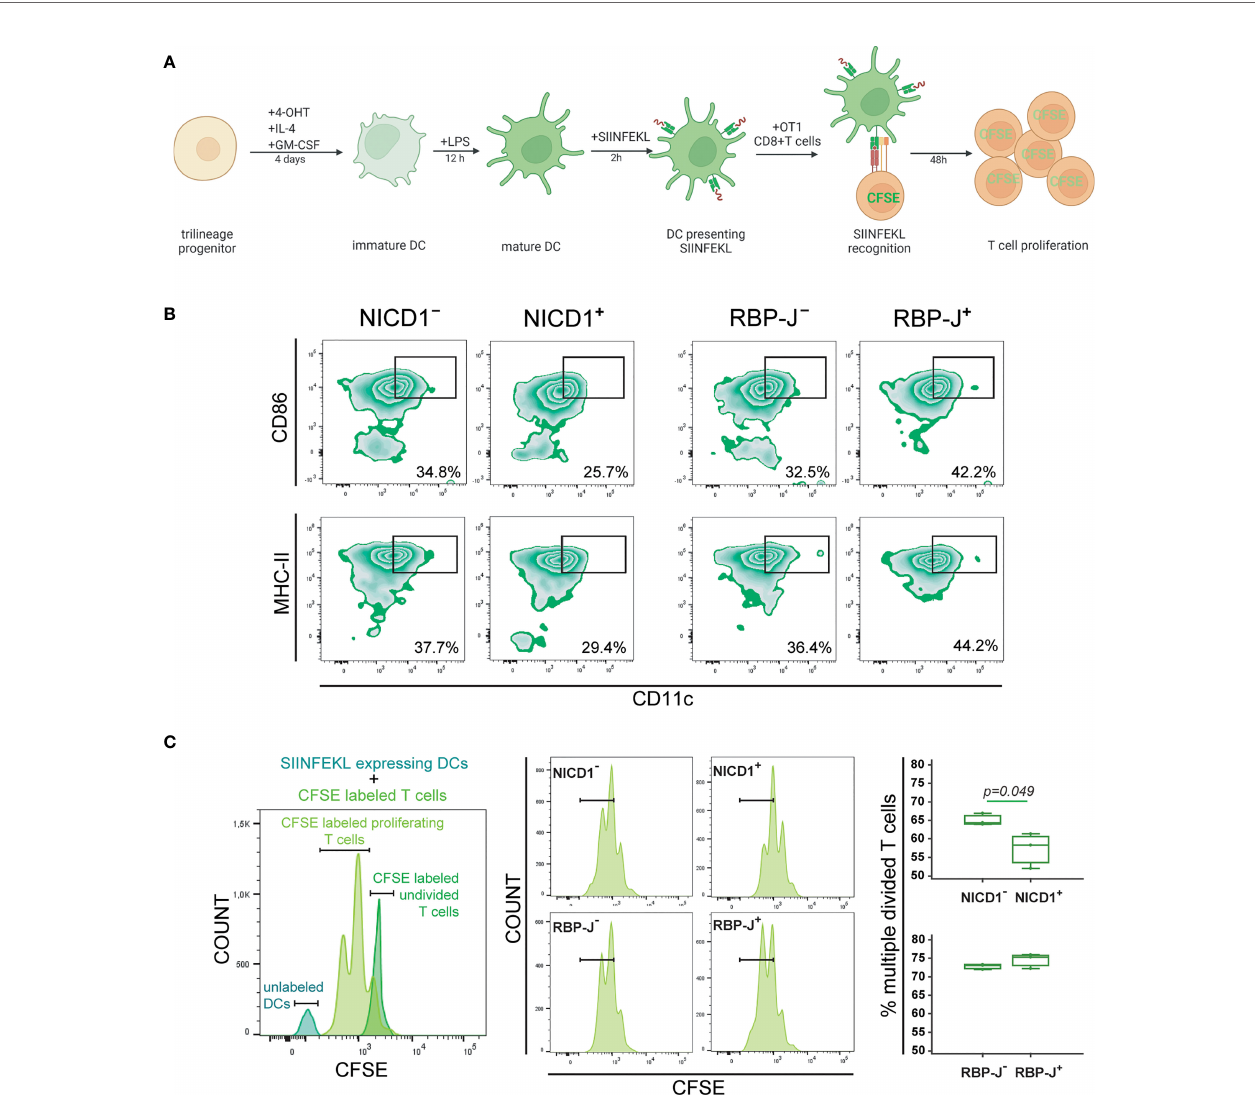
FIGURE 7 | Functional characterization of dendritic cells differentiated from the common trilineage progenitor (TLP) isolated from bone marrow cells of CX3CR1CreERT2/NICD1 (NICD1) and CX3CR1CreERT2/RBP-J (RBP-J) mice. Bone marrow cells were fl ushed from hind limb long bones and the common TLPs were identi fi ed as CD45 + Ly6G − CD3 − B220 − NK1.1 − CD11b – /lo CD115 + cells using fl ow-cytometry. TLPs were sorted and plated under appropriate culture conditions. CD8 + T cells were sorted from spleens of OT-1 mice. (A) Experimental design of dendritic cell differentiation and functional testing. Dendritic cell differentiation was induced by the addition of interleukin 4 (IL-4) and granulocyte-macrophage colony-stimulating factor (GM-CSF). Cre-mediated recombination in Cre + (NICD1 + or RBP-J + ) littermates was induced by the addition of 4-hydroxytamoxifen (4-OHT). Cre − (NICD1 − or RBP-J − ) littermates treated with 4-OHT were used as controls. Lipopolysaccharides from E.coli (LPS) were added 12h before co-culture with OT-1 T cells to induce the in fl ammatory response. Presentation of SIINFEKL and proliferation of CFSE-labeled CD8 + OT-1 T cells was used as a functional assay. Created with BioRender.com (B) Expression of CD86 and MHCII on CD11c + mature dendritic cells from NICD1 and RBP-J TLPs, stimulated by LPS. Representative dot plots showing CD86 + CD11c + and MHCII + CD11c + subpopulations. (C) Quanti fi cation of divided CFSE-labeled OT-1 T cells co-cultured with SIINFEKL-expressing LPS-stimulated dendritic cells. Representative histogram showing undivided CFSE-labeled OT-1 T cells, proliferating CFSE-labeled OT-1 T cells and unlabeled dendritic cells (DCs) ( left ). Representative histograms of proliferating CFSE-labeled OT-1 T cells from Cre + and Cre − littermates ( middle ). Percentage of divided CFSE-labeled OT-1 T cells co-cultured with SIINFEKL-expressing LPS- stimulated dendritic cells ( right ). Individual values are presented (n=3); horizontal lines represent the median, boxes represent the interquartile range (IQR), whiskers represent 1.5 times the IQR. Statistically signi fi cant difference was determined at p<0.05, Mann – Whitney